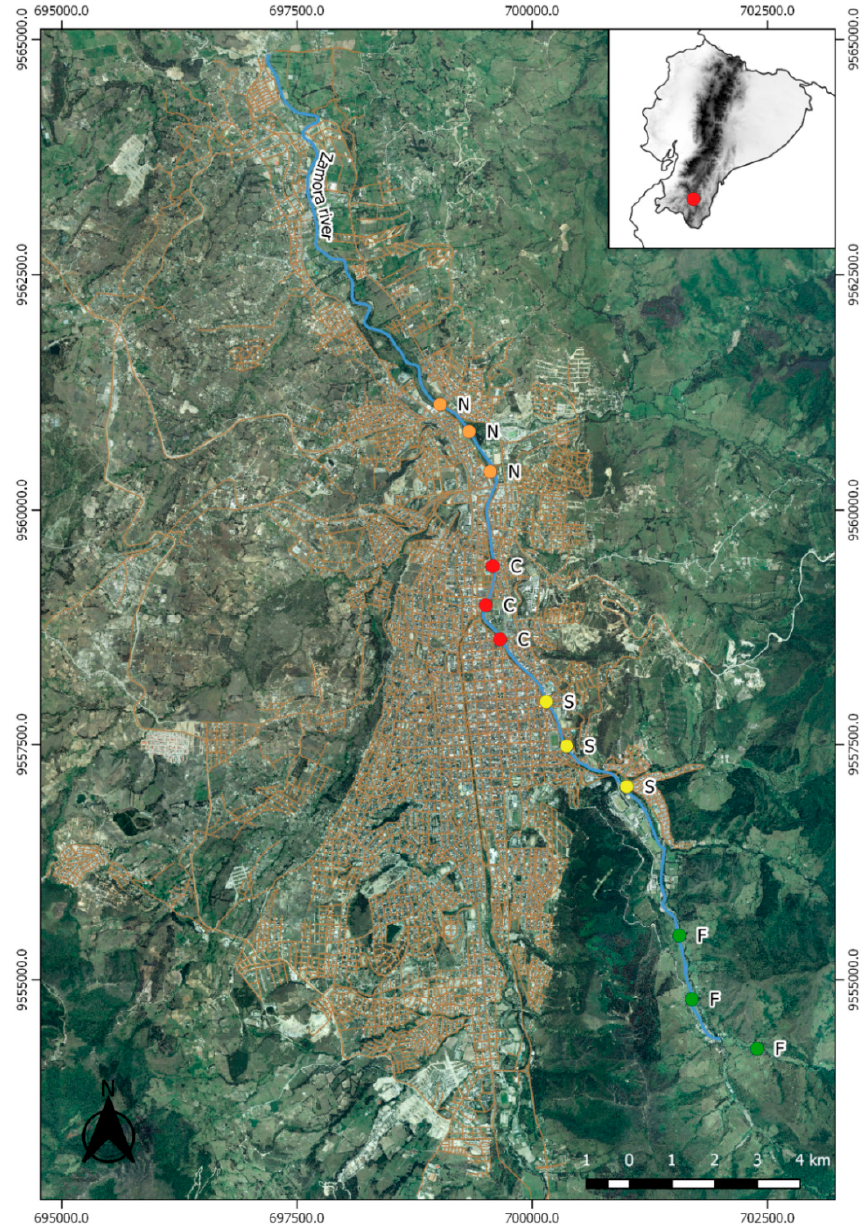
Figure 1. Study area in Loja Province in southern Ecuador showing the location of four study zones. Control zone (F), south zone (S), center zone (C), and north zone (N).